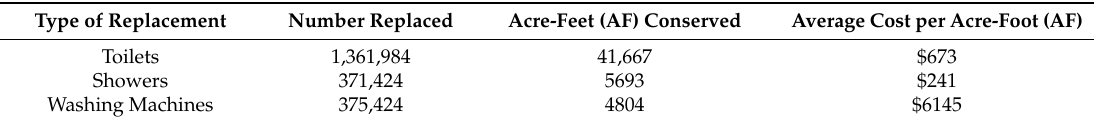
Table 2. Indoor Residential